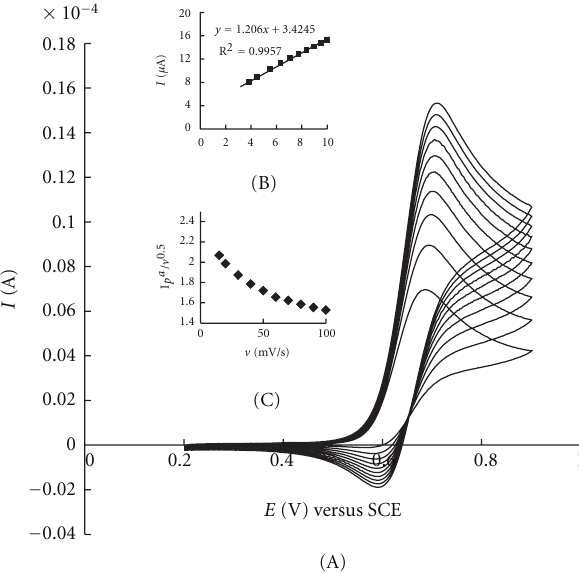
Figure 4: (A) Cyclic voltammograms of CPZ solution (1.5 mM) on a GCE and in the presence of CAP (0.5 mM) at various scan rates; from bottom to top: 20, 30, 40, 50, 60, 70, 80, 90, and 100 mVs − 1 in phosphate bu ff er solution (pH 4.0, 0.05 M). (B) Plot of i a p versus ν 1 / 2 . (C) Plot of normalized anodic peak current versus ν